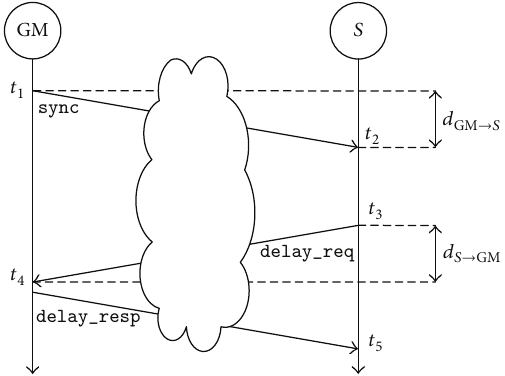
Figure 2: Clock synchronization